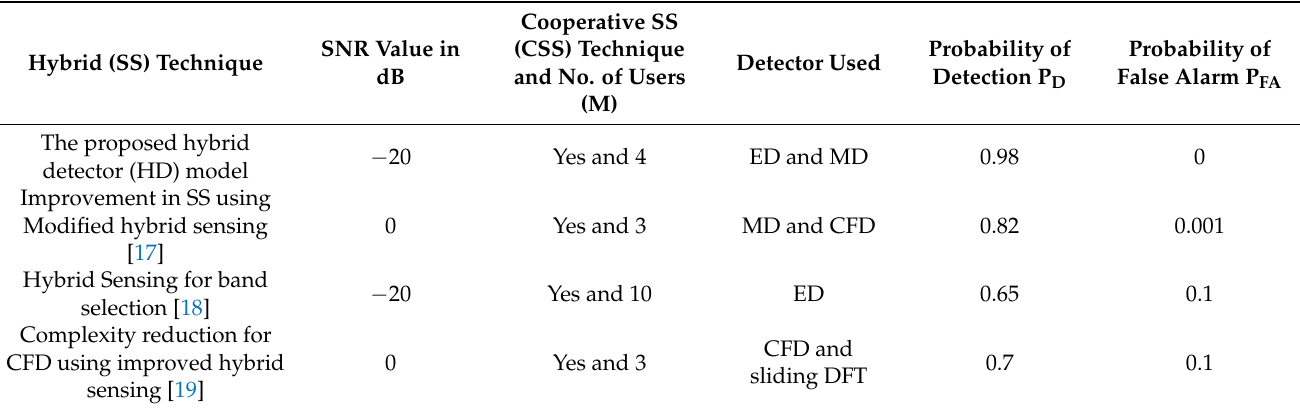
Table 4. Comparison of hybrid SS techniques based on parameters required for IEEE 802.22 WRAN stan-